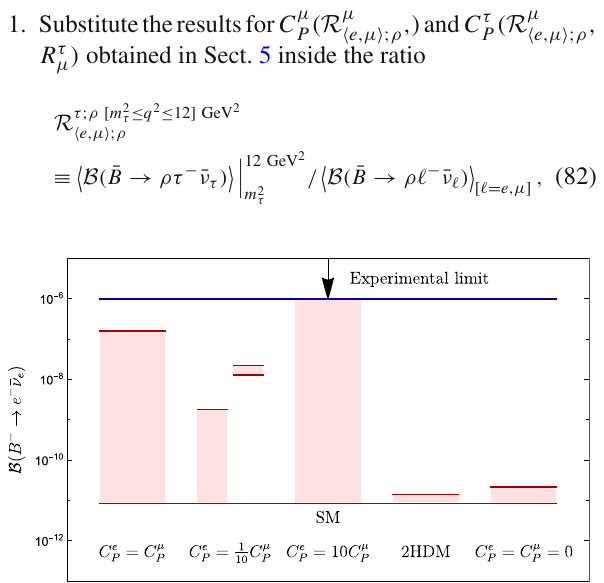
Fig. 18 Illustration of the possible enhancement of B ( B − → e − ¯ ν e ) for the scenarios discussed in the text. The blue line gives the current experimental upper bound on B ( B − → e − ¯ ν e ) , whereas the red hor- izontal line on the bottom represents the SM value. The red regions indicate the values of the branching ratio that may be obtained